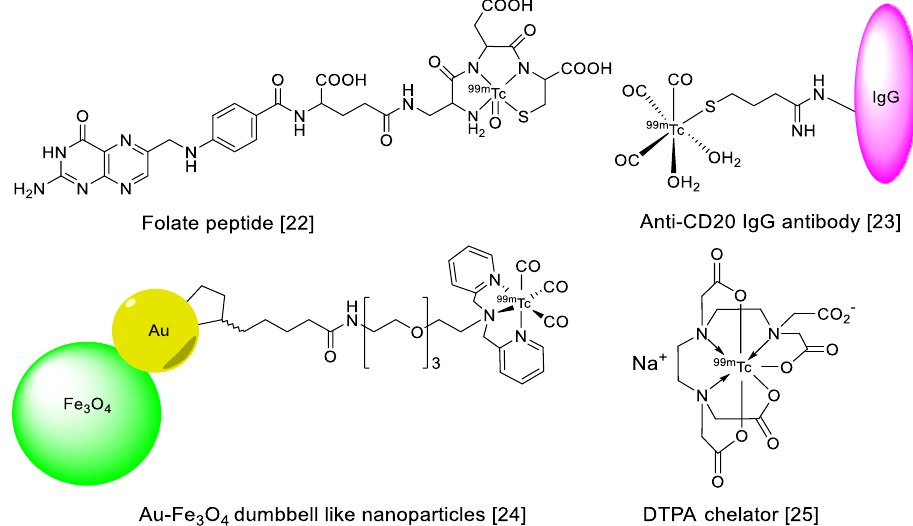
Figure 1. Examples of 99m Tc radiolabeled biomolecules and nanoparticles [22 – 25].